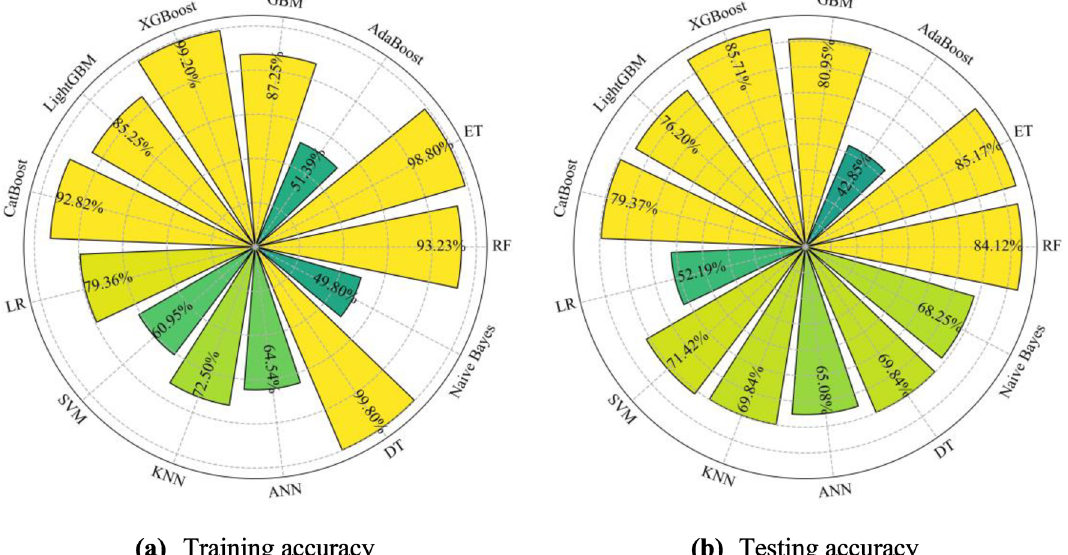
Figure 9. The performance comparison of ensemble trees and other ML